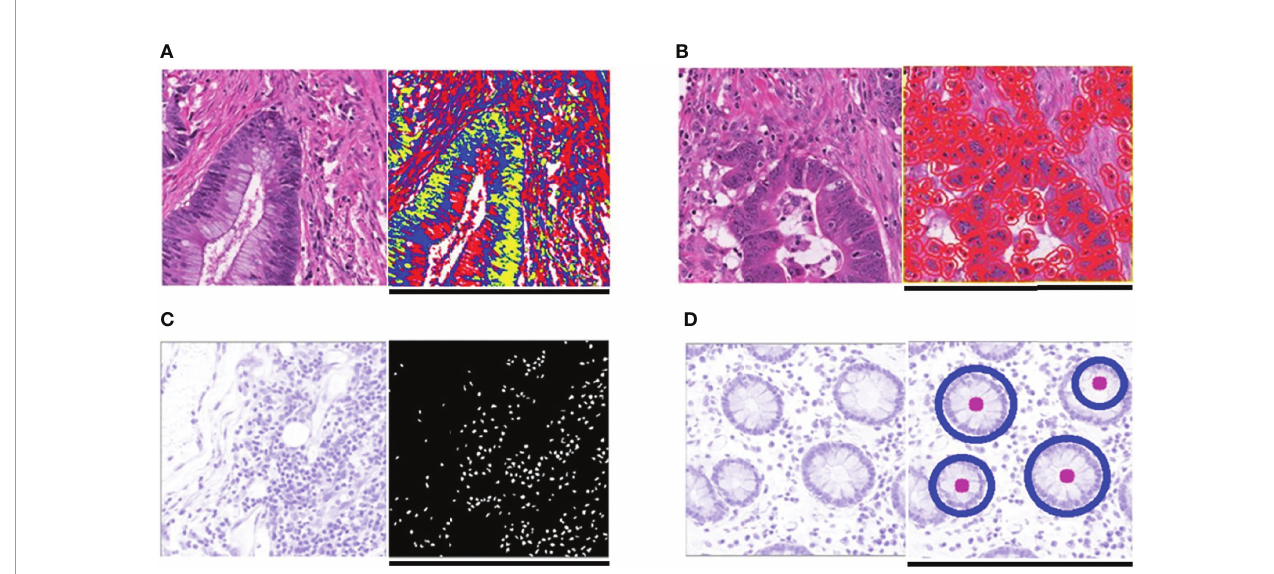
FIGURE 3 | Typical feature extraction result. (A) GMM model for image segmentation. The fi gure on the left is a tile from the TCGA-CC-DX dataset, and its image segmentation tiles processed by the GMM method are shown in the fi gure on the right. The green part whose grayscale is the lowest among the three parts tends to be tumor tissue, whereas the blue and red ones represent non-tumor tissue. (B) Tumor cell detection before Haralick texture identi fi cation. The fi gure on the left is an original tile, whereas the one on the right is processed with tumor identi fi cation. Each red circle in the tile on the right indicates the boundary of one tumor cell. (C) In fi ltrating immune cells detection. The detection of immune cells allows us to calculate the connectivity domain. (D) The grading of differentiation. Detect the circularly similar arrangement in one slice and grade the degree of differentiation based on its amount. Scale bar, 256